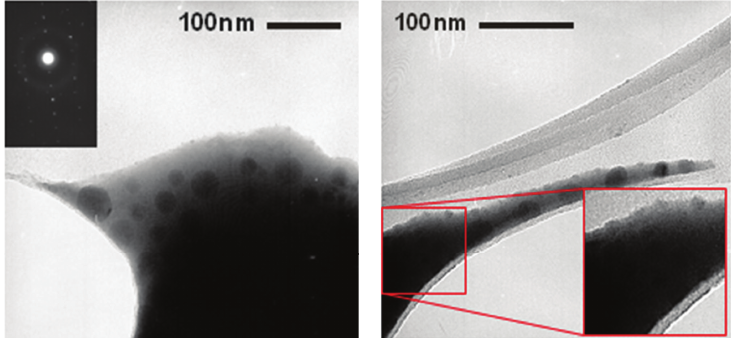
Figure 17: Transmission electron microscope images of TBW-Er:Ag sample with silver NPs after heat-treatment of 24h [4].